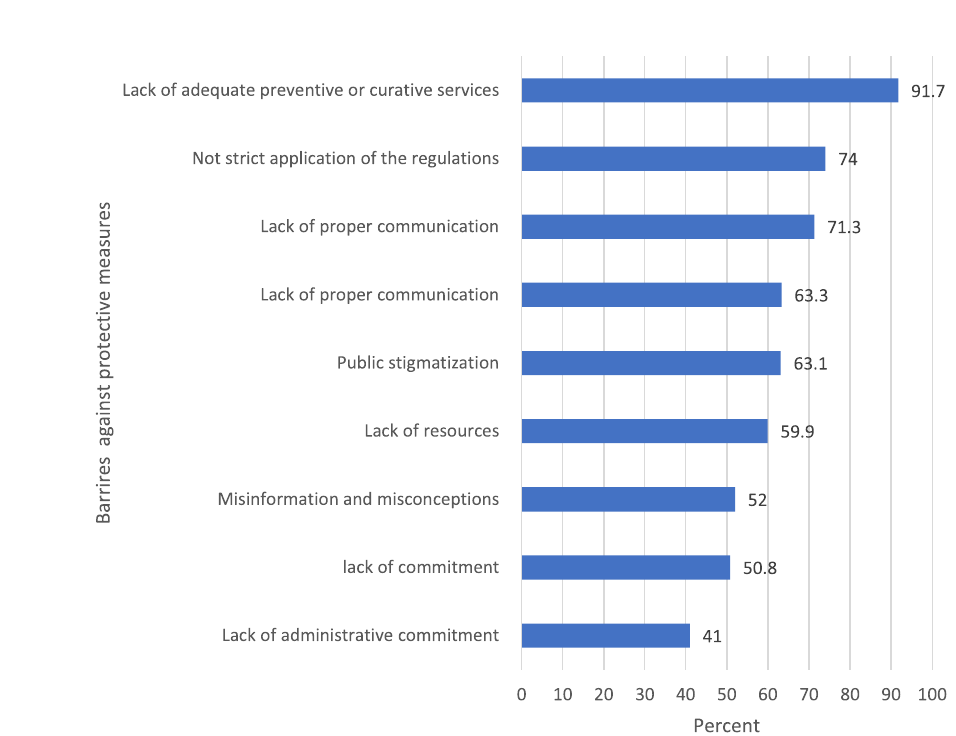
*Statistically significant at p <0.05 a ANOVA test